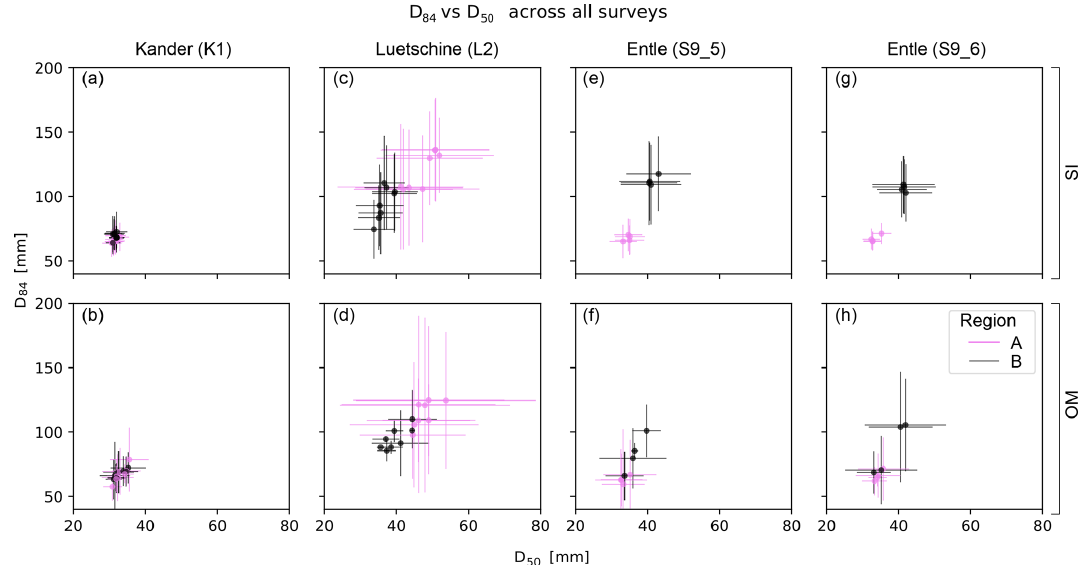
Figure 7. Modeled median grain size percentile D 50 plotted against the D 84 for all surveys: Kander (a, b) , Luetschine (c, d) , Entle (e–h) , and regions of grain size sampling (A and B). For locations of the regions, see Fig. 1. OM: orthophoto mosaics: SI: single